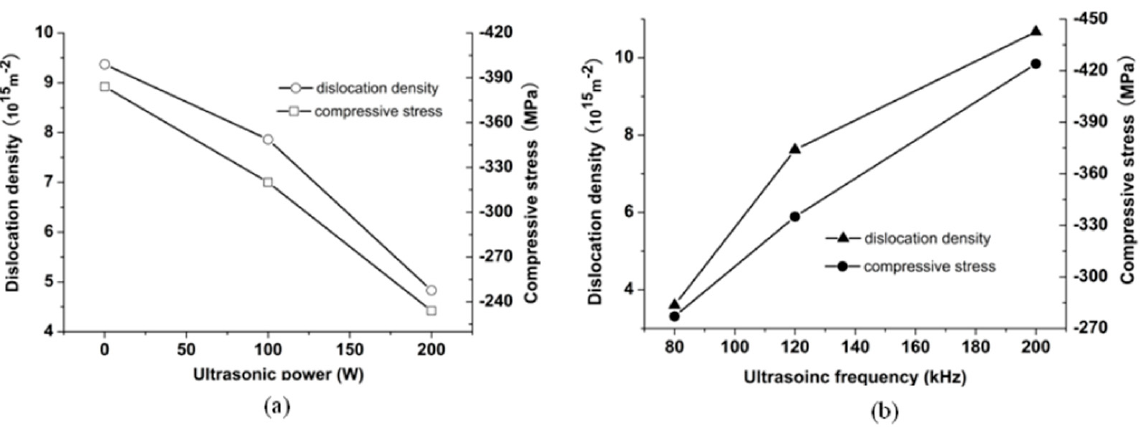
Figure 9. The influence of the ultrasonic activation on the dislocation density and the compressive stress of the electroplated Ni coating: ( a ) ultrasonic power; ( b ) ultrasonic frequency.